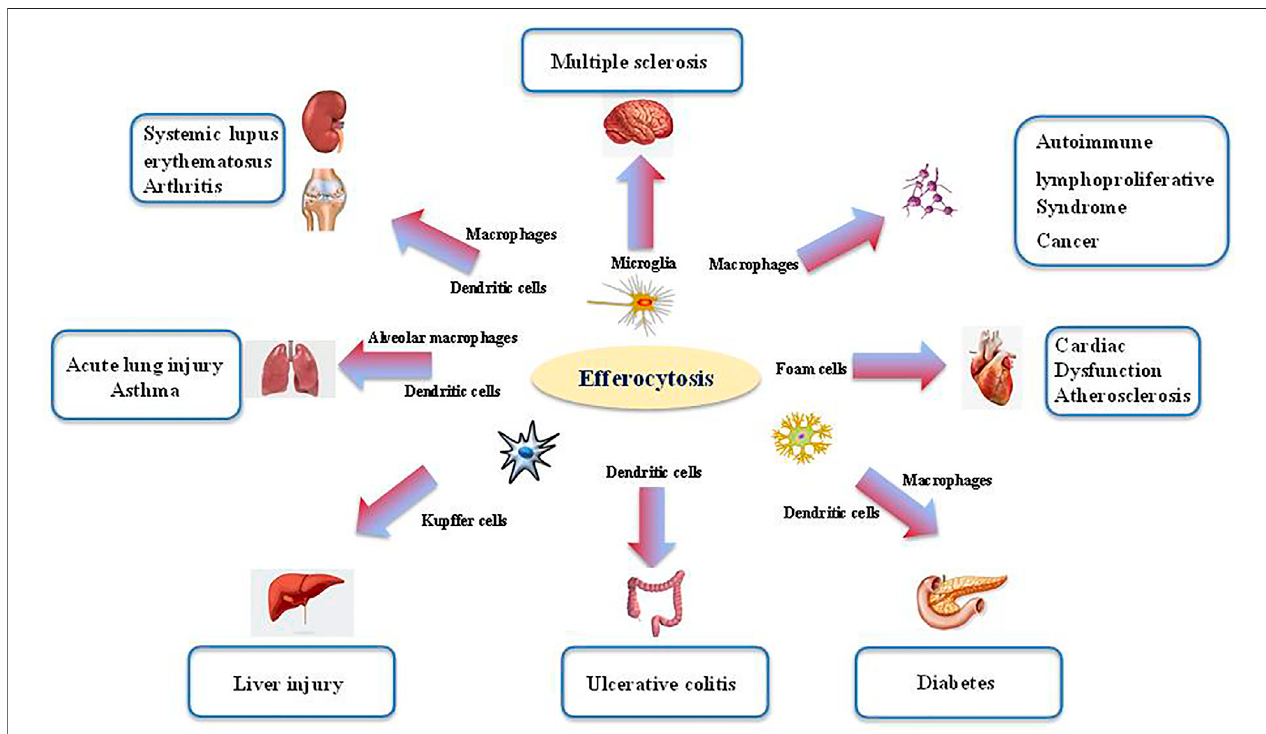
FIGURE 3 | The role of efferocytosis in various in fl ammatory disorders. Efferocytosis is required for tissue homeostasis and organ development. The process is mainly orchestrated by several phagocytes (i.e., microglia, macrophage, dendritic cells). Aberrant efferocytosis has been associated with several in fl ammatory and autoimmune disorders, including infection, acute lung injury (ALI), asthma, systemic lupus erythematosus (SLE), rheumatoid arthritis (RA), diabetes, multiple sclerosis (MS), autoimmune lymphoproliferative syndrome (ALPS) and other in fl ammatory conditions.